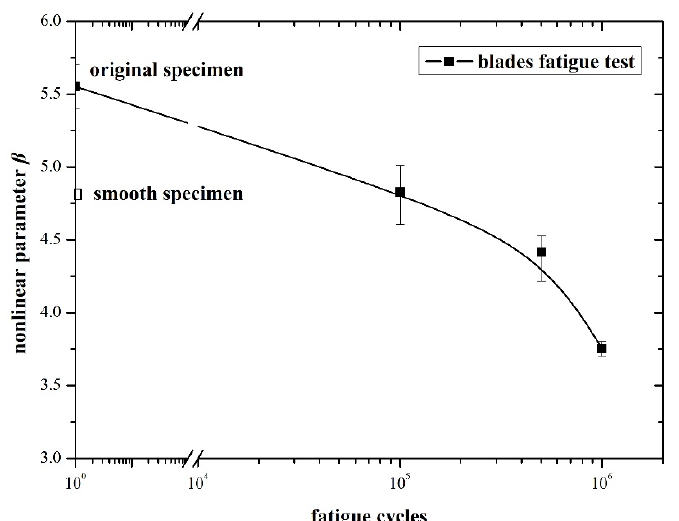
Figure 9. Relationship curve between nonlinear coefficient and fatigue cycles of KMN blade fa- tigue specimen.